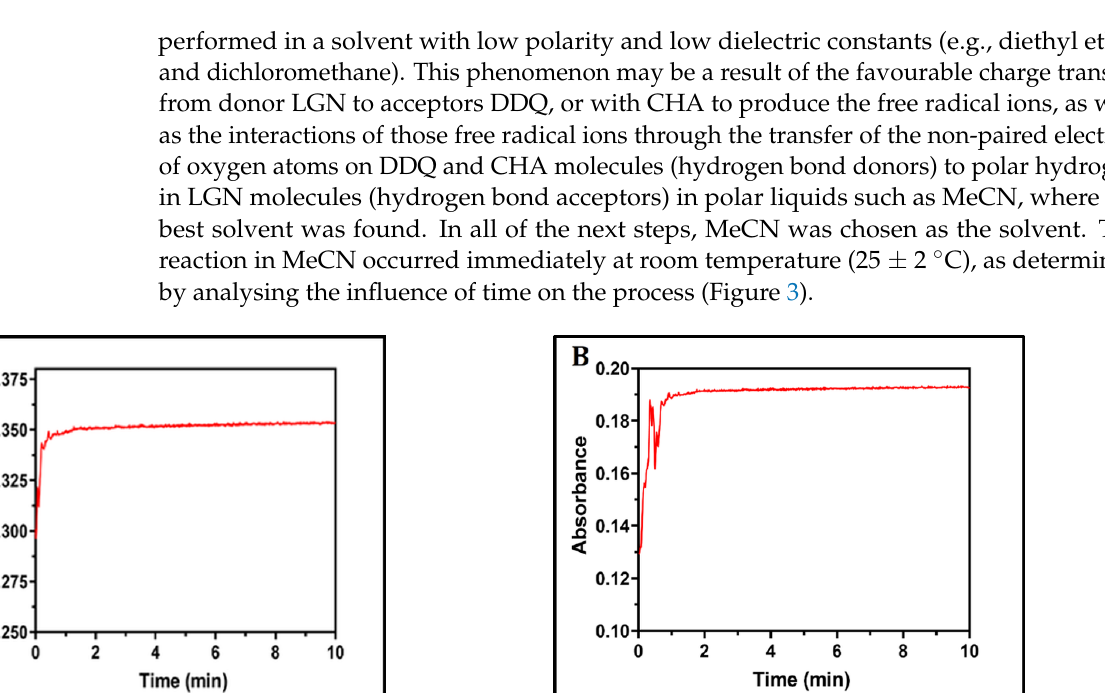
Figure 2. Effect of solvent on the absorption spectrum of the complexes of LGN 50 with ( A ) DDQ and ( B ) CHA.